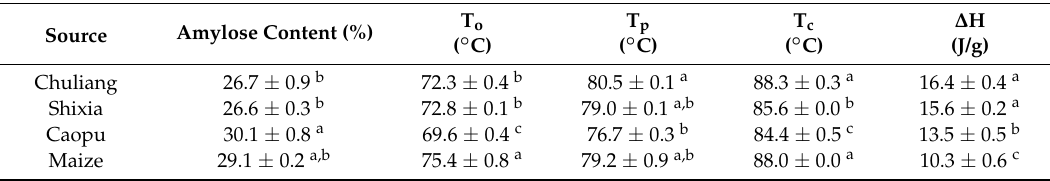
Table 2. Amylose content and thermal properties of longan seed starch from various cultivars in comparison with normal maize starch 1